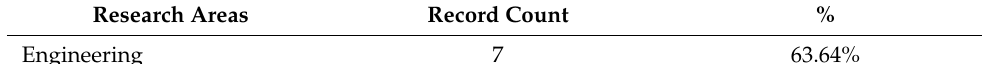
Table 8. The main area of science to which the analyzed articles were classified; Source: own study.